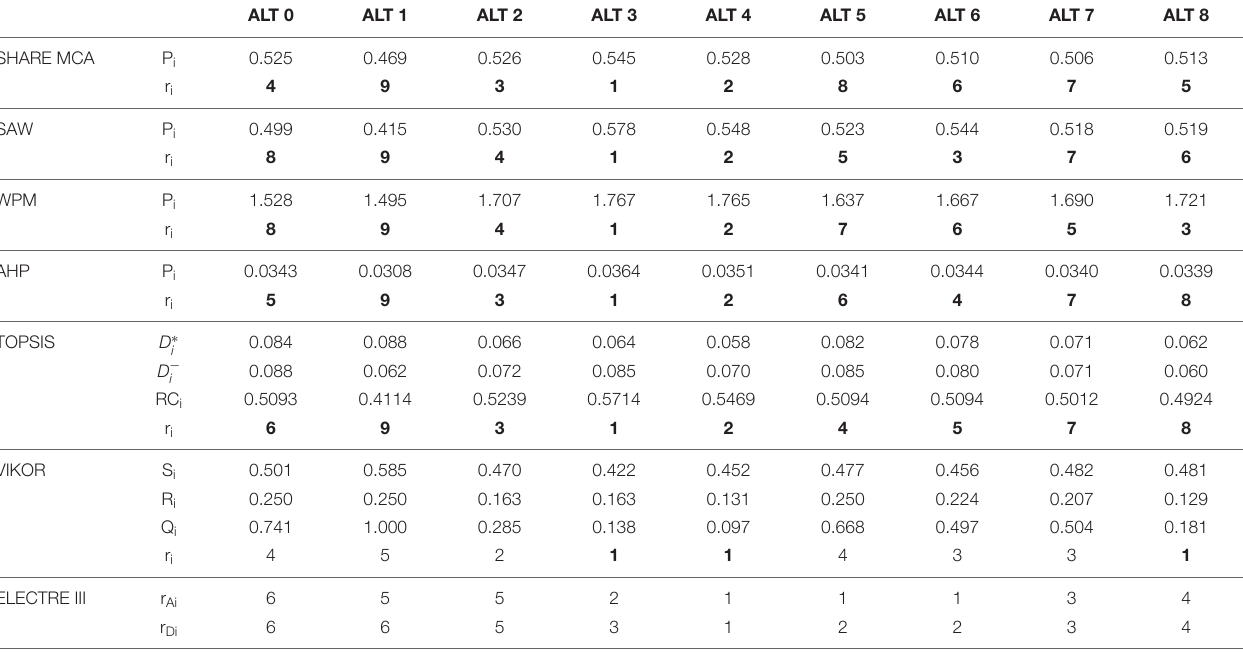
Bold type is used to highlight the compromise solutions for VIKOR and all the ranking positions for the other